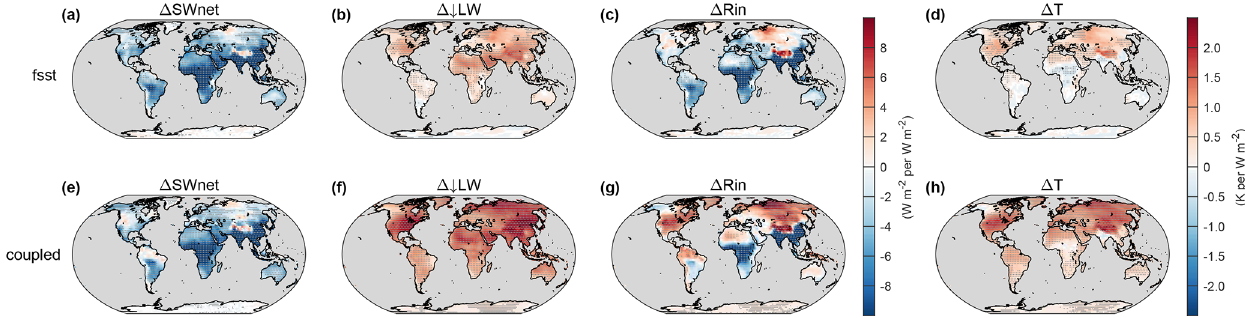
Figure 2. MMM changes of surface net SW radiation, downward LW radiation, incoming radiation ( R in ), and surface air temperature in the fsst (a–d) and coupled simulations (e–h) for the BC experiment. All changes are normalized to changes per unit of global forcing. Grey dots indicate that the MMM changes are significant at a p value of 0.05.